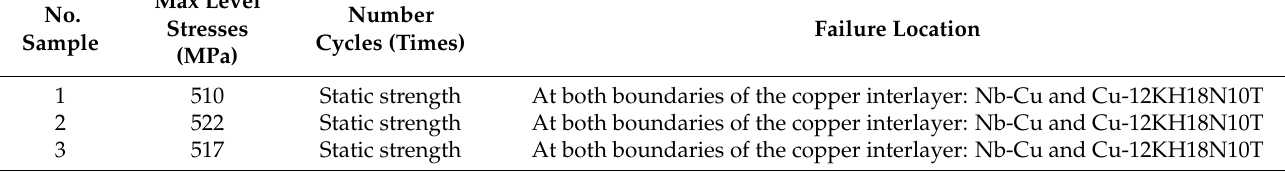
Table 12. Cyclic test